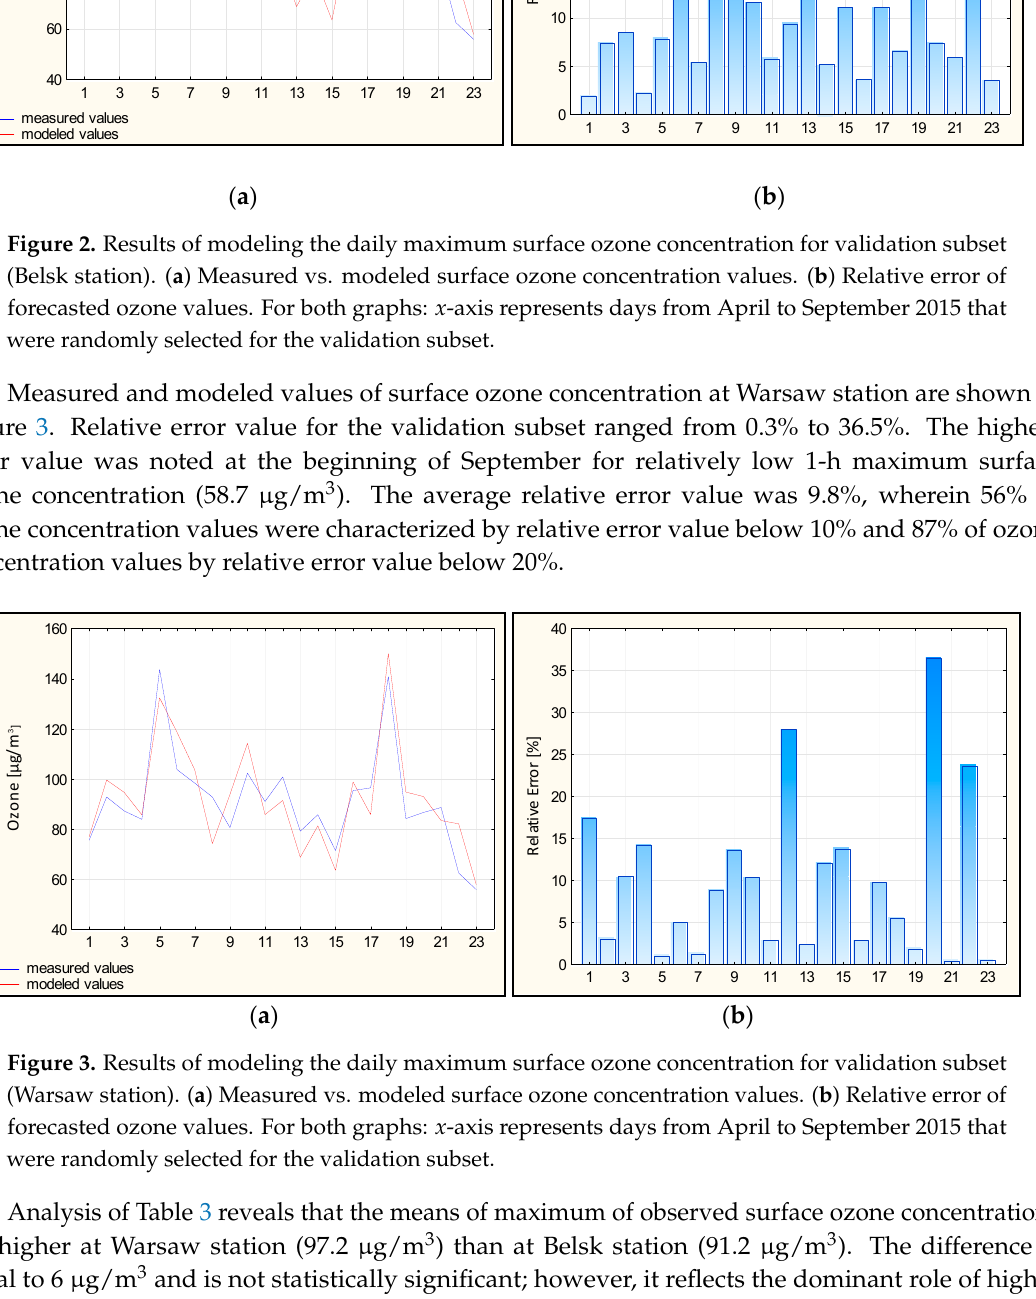
Table 3. Statistical performance of the neural network models for data set from 2015. O and A -mean maximum observed and predicted concentration (µg/m 3 ), respectively; So and Sa—standard deviation of observed and predicted concentration (µg/m 3 ), respectively; R 2 —coefficient of